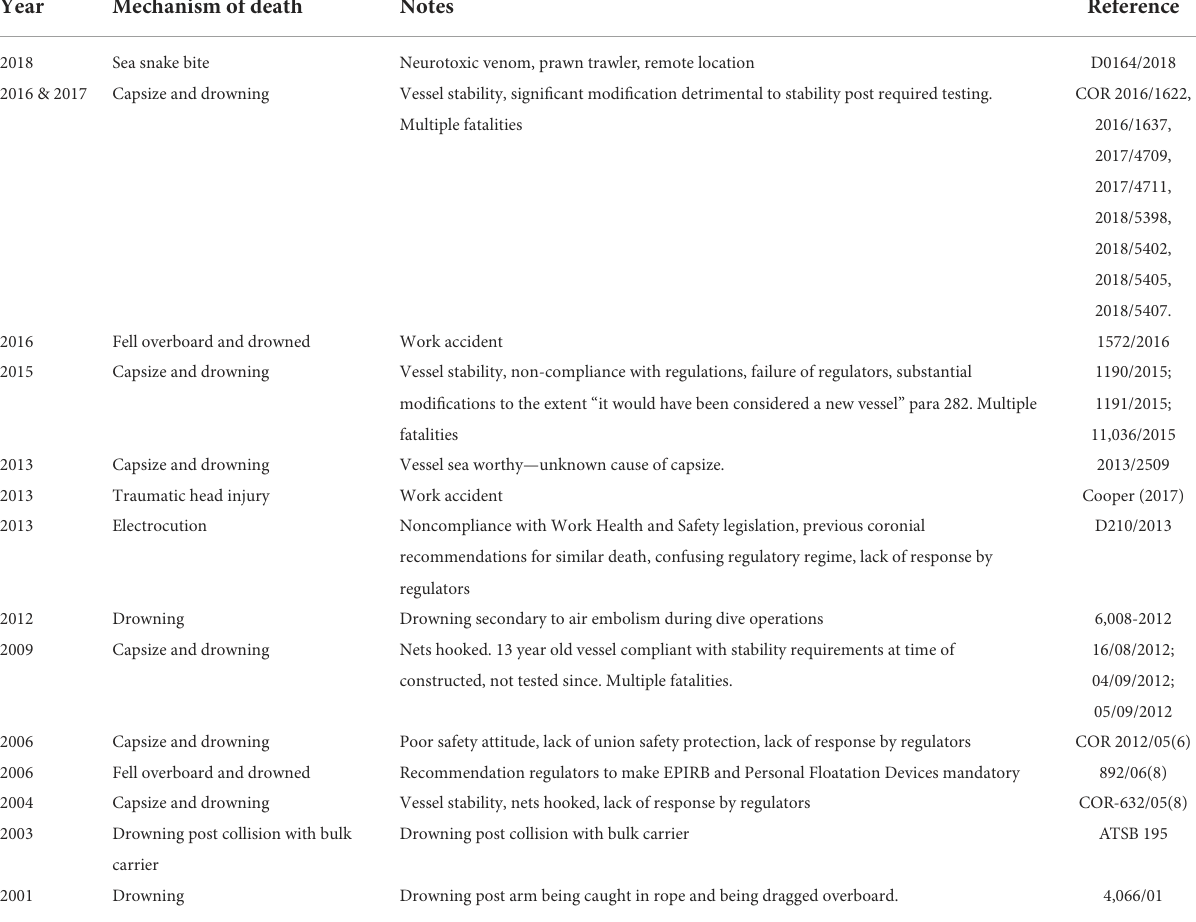
TABLE 3 Coronial finding and ATSB report summary.